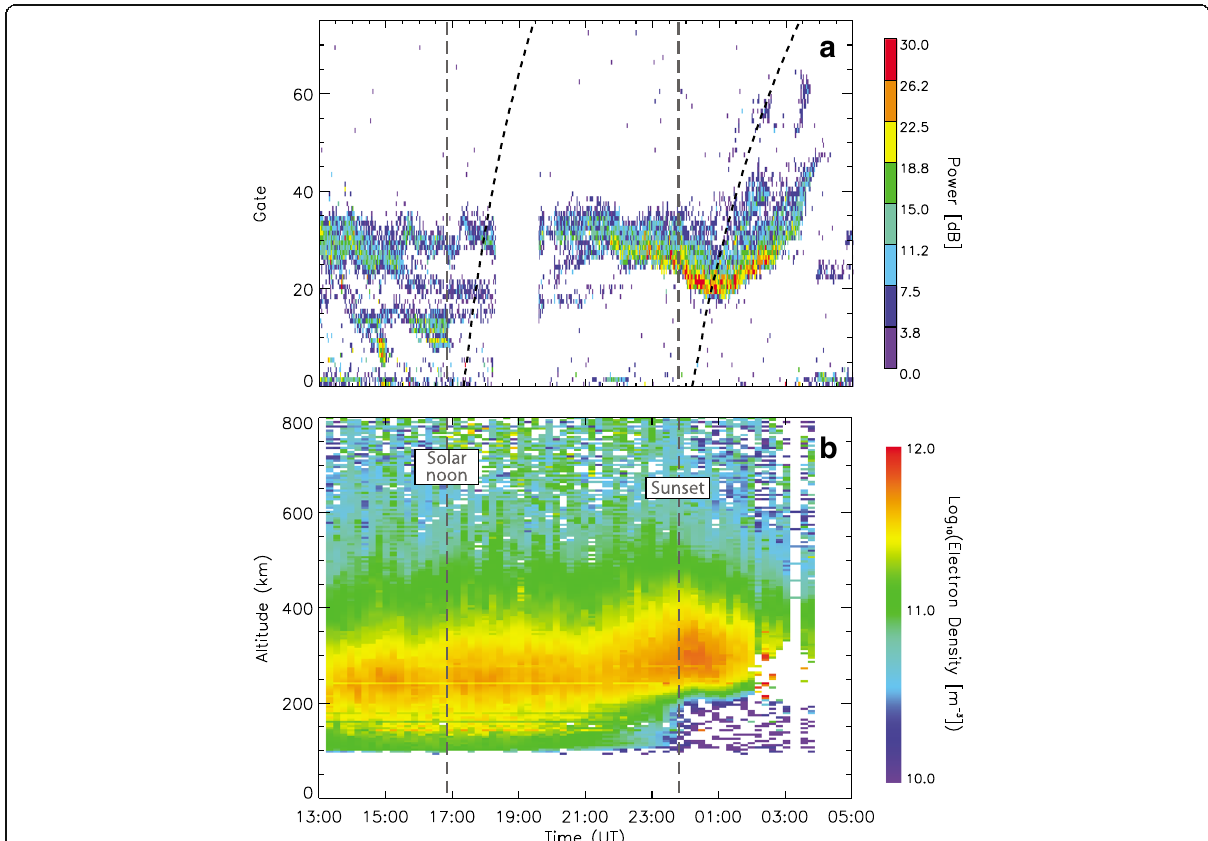
Fig. 23 Observations of the mid-latitude evening anomaly on 13 August 2010 seen in a Blackstone radar beam-7 backscattered power and b Millstone Hill ISR electron density versus altitude. Dashed lines identify solar noon and sunset. Reproduced from Fig. 5 of de Larquier et al.